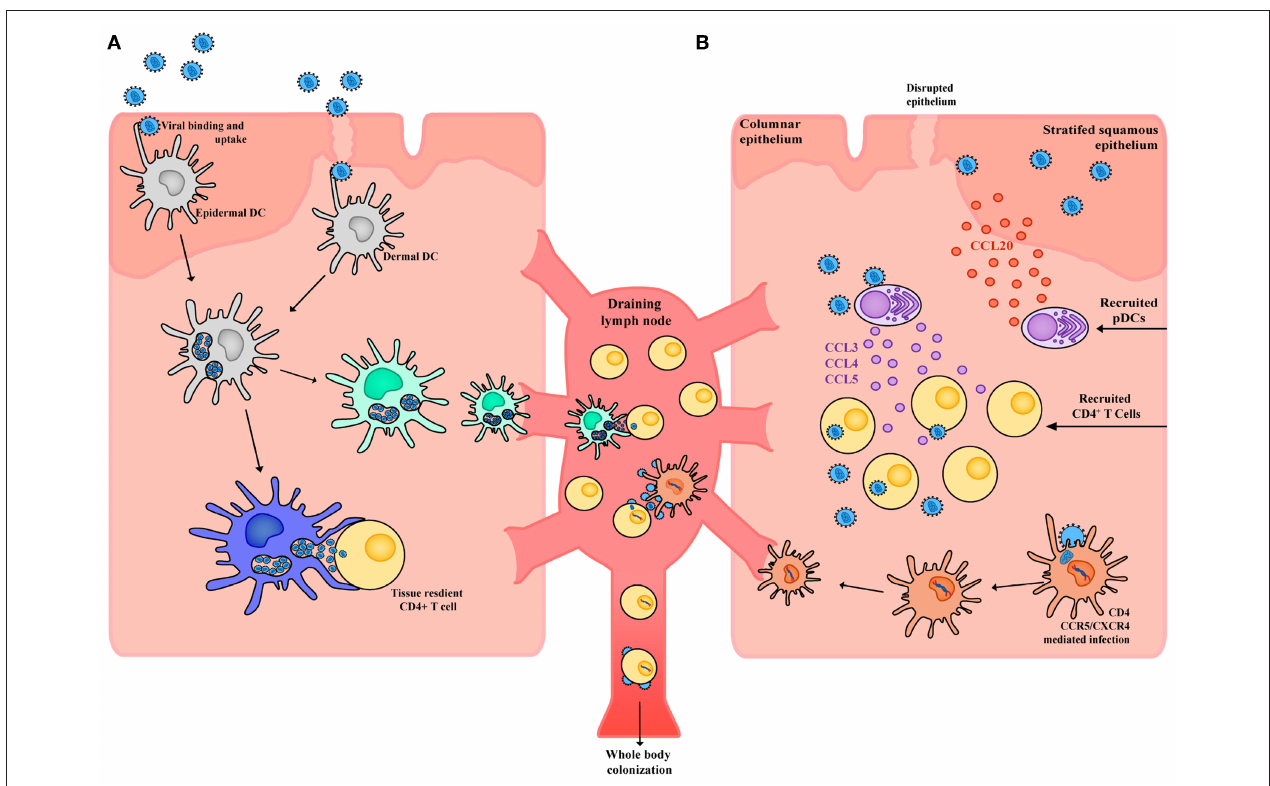
FIGURE 3 | Schematic of HIV interactions with DCs in tissue. (A) Within the stratified squamous epithelium of skin and type II mucosa epidermal DCs pick up incoming HIV virions potentially through a wide array of receptors including CLRs, syndecans, and CD169. Virus is taken up into open vesicular compartments that are more extensively formed in proinflammatory conditions. DCs harboring virus (yet not productively infected) can directly and immediately transfer the virus to tissue resident CD4 + T cells or can migrate to the draining lymph node and transfer the virus to CD4 + T cells that reside there. For the latter to occur, maturation of DC subsets will increase the half-life of HIV to enable efficient transfer. (B) Whilst in immature DCs, the half-life of captured HIV would not be conducive to transfer after migration in draining lymph nodes. Given immature DCs are susceptible to infection, latter viral transfer may proceed if they are infected. From here the DC migrates to the draining lymph node and productively infects CD4 + T cells. Of note, whilst DCs may not be highly susceptible to HIV infection, low frequency infections can still lead to robust viral transfer when in contact with CD4 + T cells. This is analogous to communication of the immune response by DCs, where only limiting numbers can still mediate a productive immunological outcome. Finally, in response to HIV infection epithelial cells can produce CCL20 which drives the migration of pDCs into the tissue. These pDCs in turn produce high levels of CCL3, CCL4, and CCL5 which drive migration of CD4 + T cells into the tissue, increases CCR5 expression and in doing so further facilitates local HIV infection and